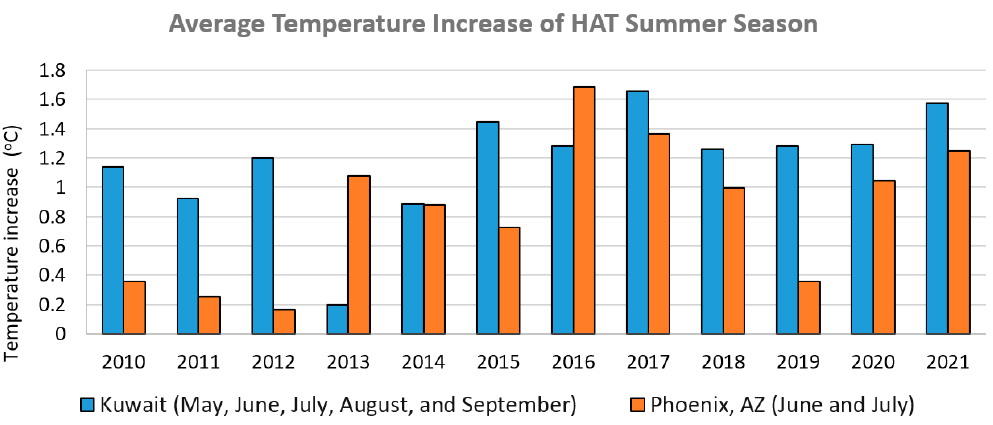
Figure 4. Average temperature increase for Kuwait and Phoenix, Arizona, USA with respect to the average temperatures for the period from 1981 to 2010 [125].